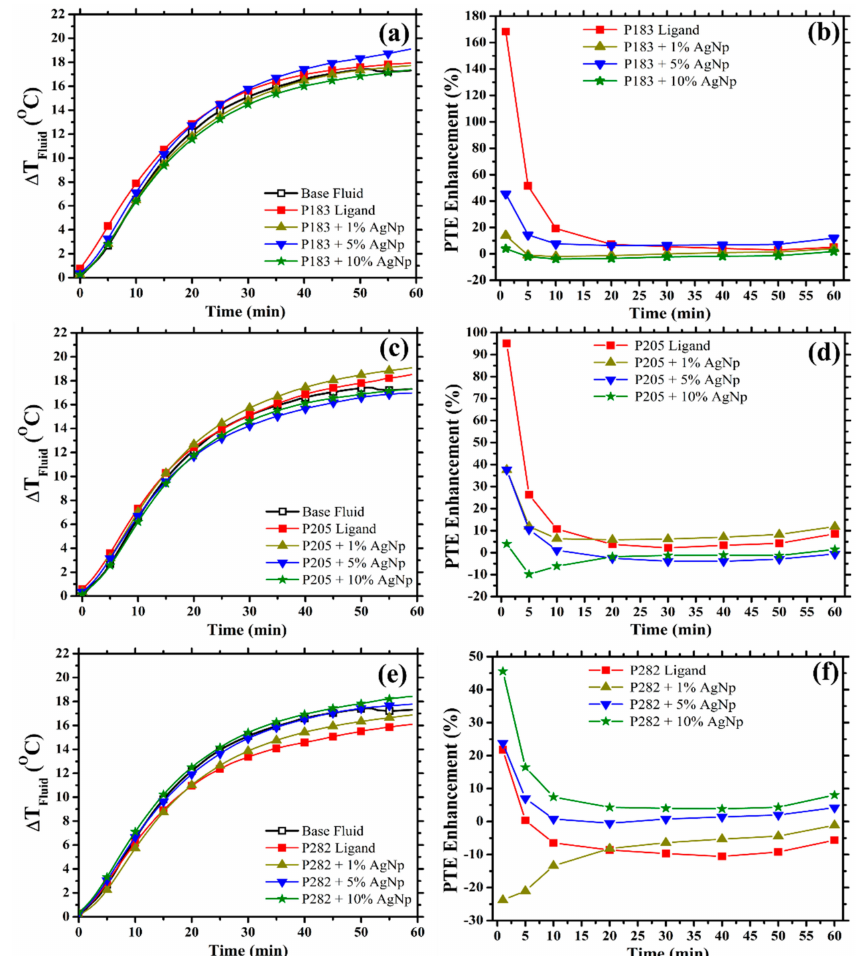
Figure 3. Variation in the temperature response ( ∆ T Fluid ) of the PLDS nanolfuid filters (( a )—P183, ( c )—P205, ( e )—P282) and the accompanying change in the PTE enhancement (( b )—P183, ( d )—P205, ( f )—P282) under 1000 W m − 2 solar simulator exposure. The performance of the pristine base fluid (ethylene glycol) is provided for